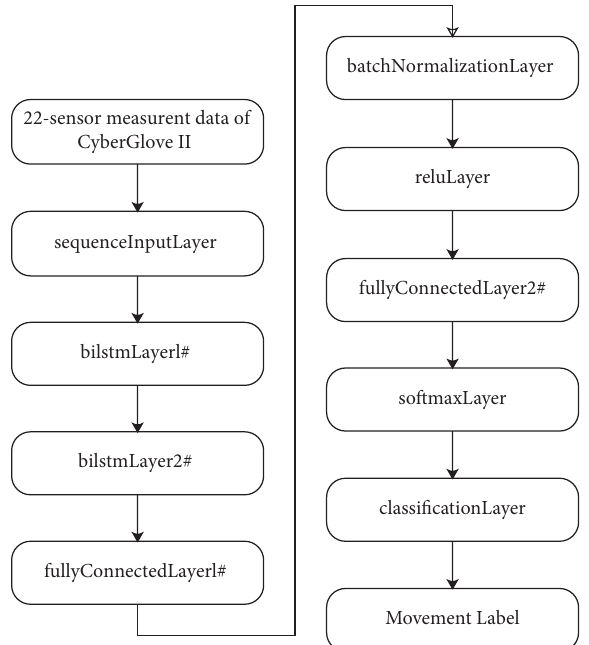
Figure 4: The structure of the DBDF network.